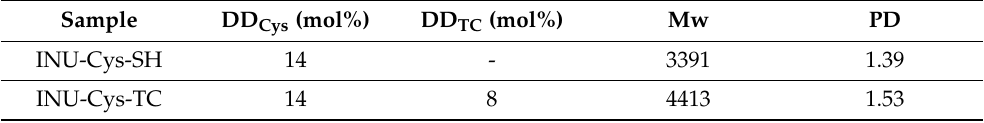
Table 1. Derivatization degree (DD) calculated by 1 H NMR, the average weighted molecular weight (Mw), and polydispersity (PD) evaluated by the SEC of inulin-derivatives.